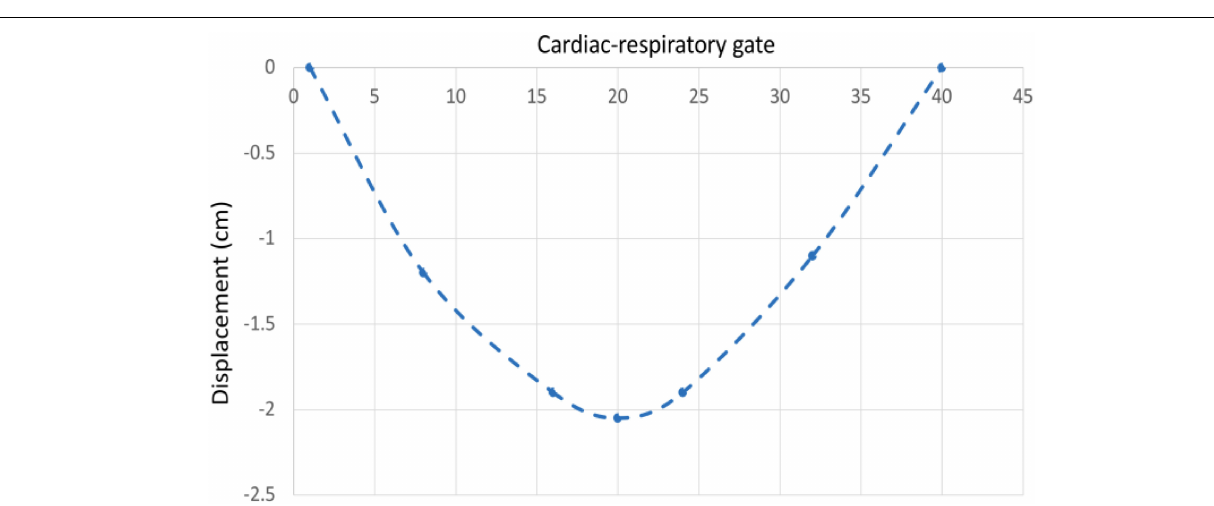
FIGURE 11 | Liver displacement over a respiratory cycle.